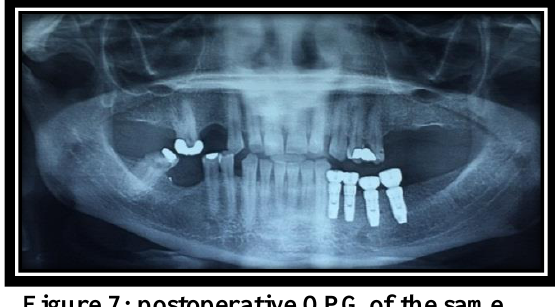
Figure 7: postoperative OPG of the same patient in figure 1 taken at 16 weeks.